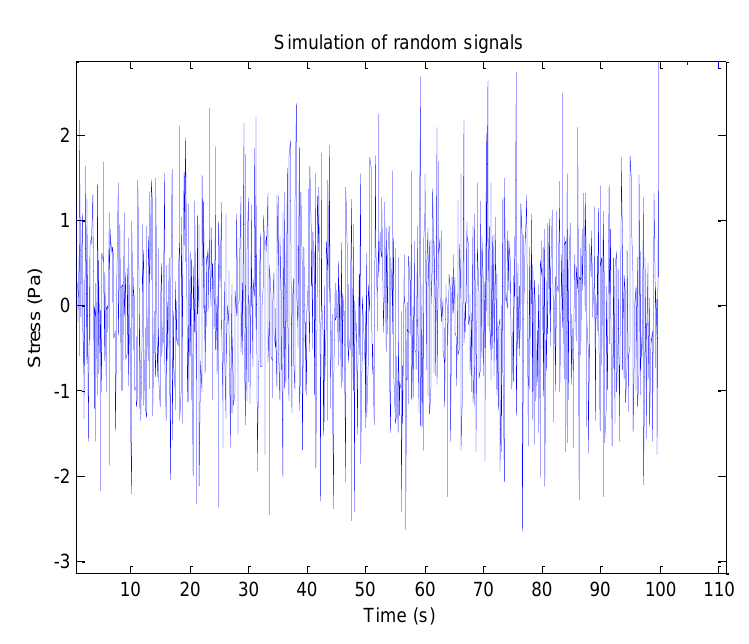
Figure 5. Numerical simulation of random signals.